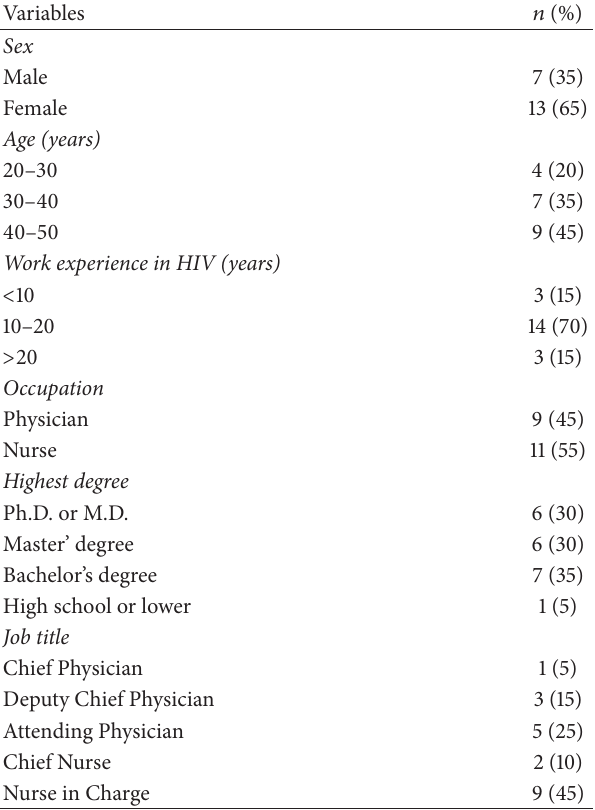
Table 1: Participant